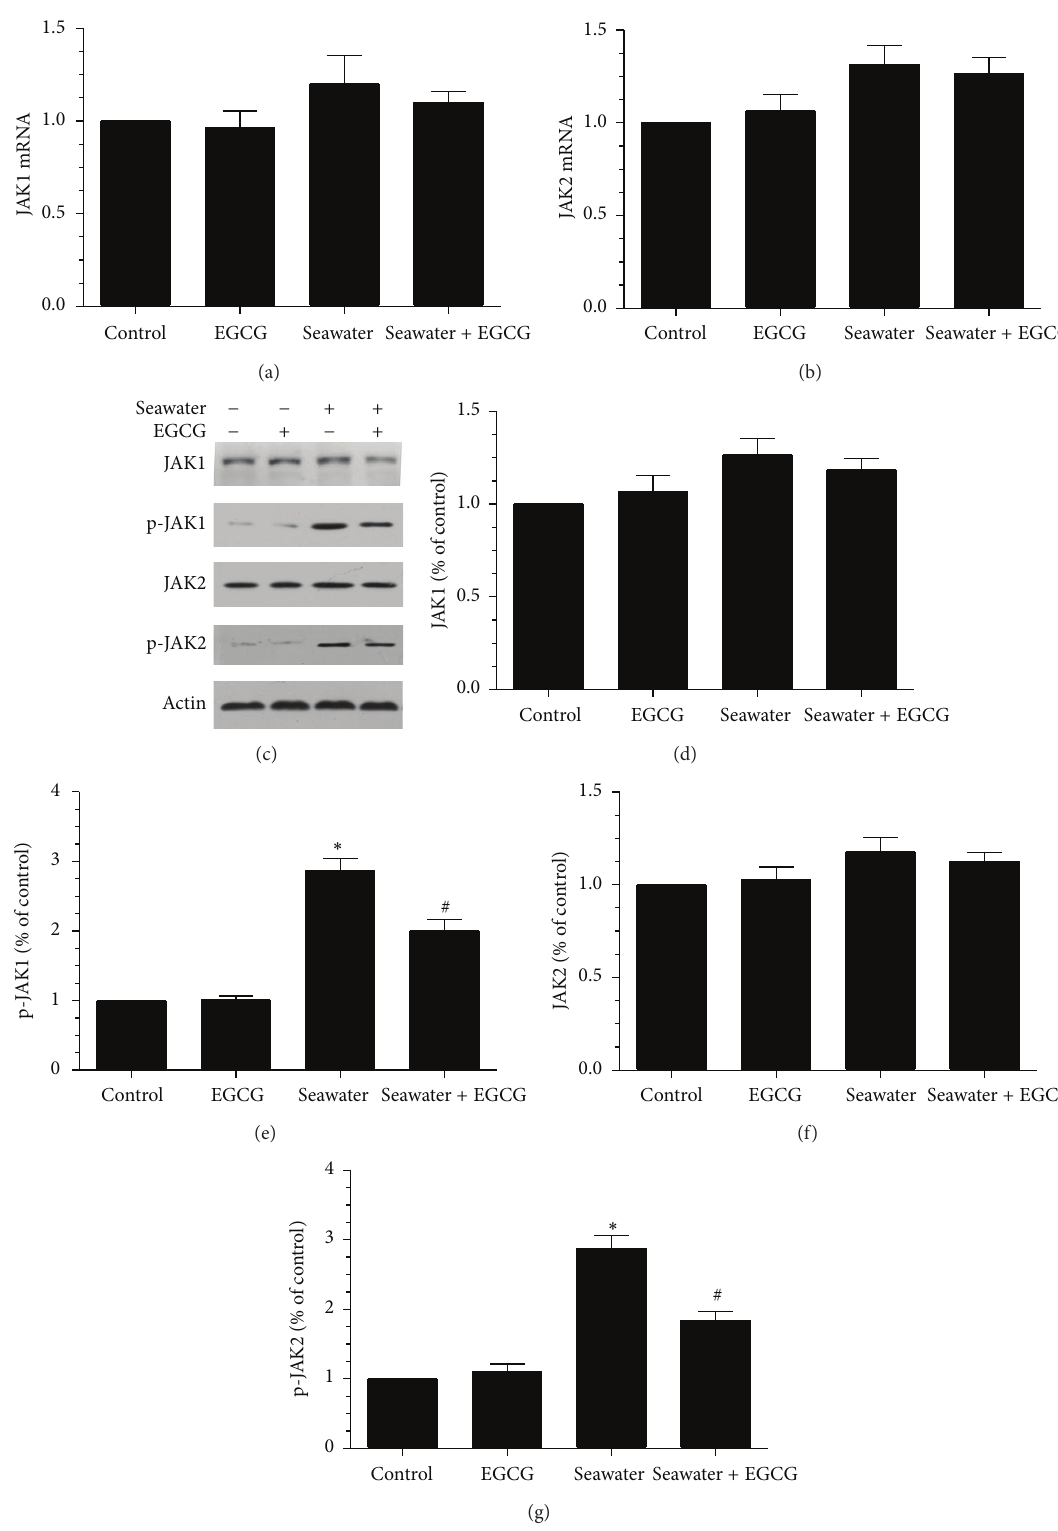
Figure 11: Effect of seawater and EGCG pretreatment on the expression of JAK1, p-JAK1, JAK2 and p-JAK2 in the cell line NR8383. (a) mRNA expression of JAK1 in NR8383 cells. (b) mRNA expression of JAK2 in NR8383 cells. (c) Representative western blot for the JAK1, p- JAK1, JAK2, and p-JAK2 protein in different groups. (d)–(g) Summarized data of the JAK1 (d), p-JAK1 (e), JAK2 (f), and p-JAK2 (g) protein level in different groups. Data represent three independent experiments and are expressed as mean ± SEM; ∗ 𝑃 < 0.05 versus control group; # 𝑃 < 0.05 versus seawater